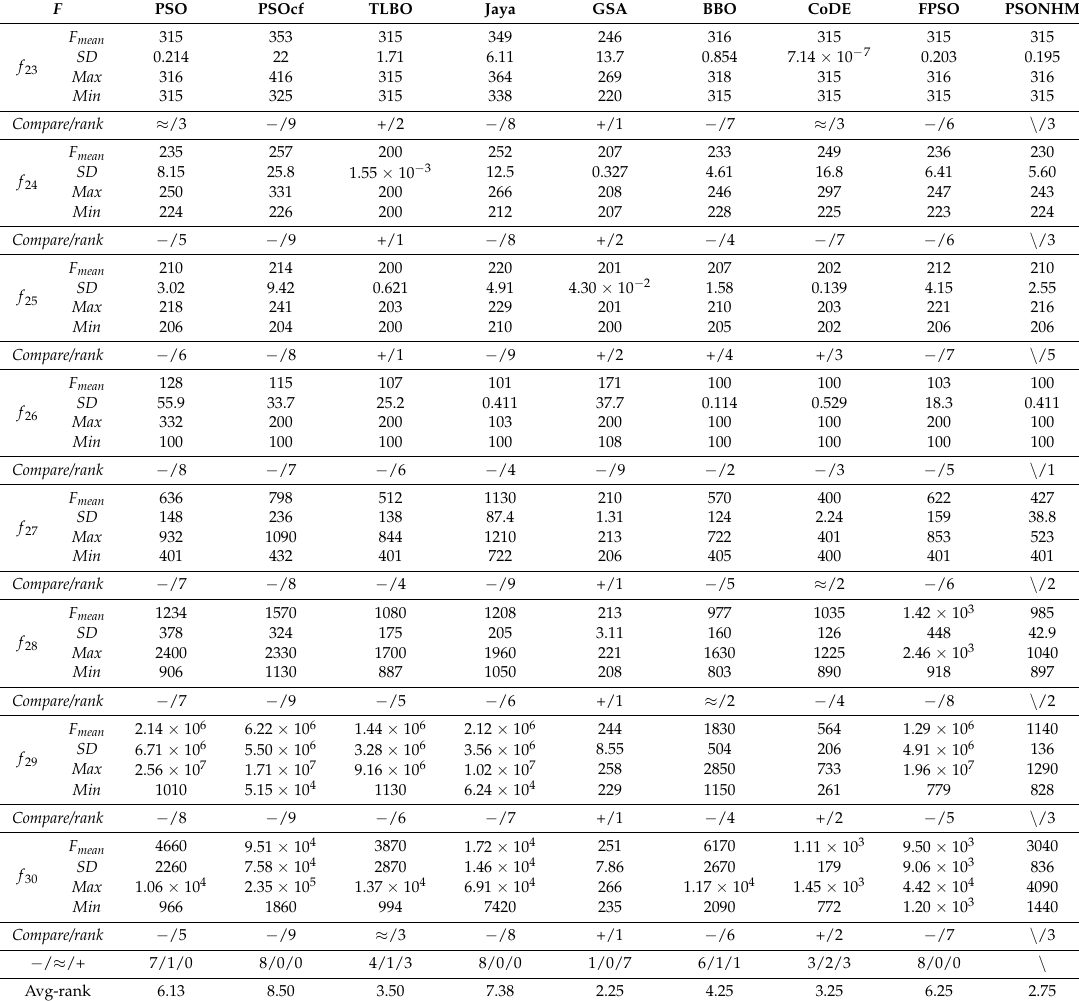
Table 5. Experimental results of PSO, PSOcf, TLBO, Jaya, GSA, BBO, CoDE, FPSO and PSONHM on f 23 – f 30